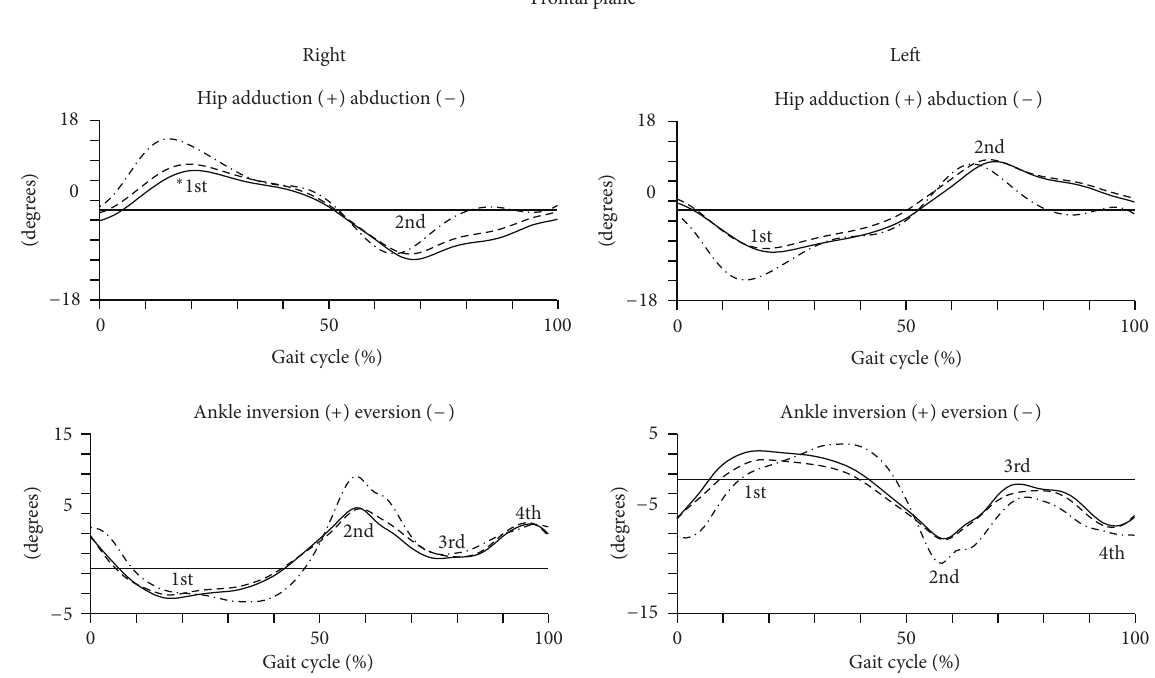
Figure 3: Kinematic parameters (frontal plane) of gait of pregnant women in the later stages of second trimester (dashed line) and third trimester (solid line) and of nulliparous controls (dot line). Mean joint angles of the hip and ankle, for right and left lower limbs, in degrees. The curve peaks are indicated by numbers: first, second, third and fourth and ( ∗ ) points the significant differences.